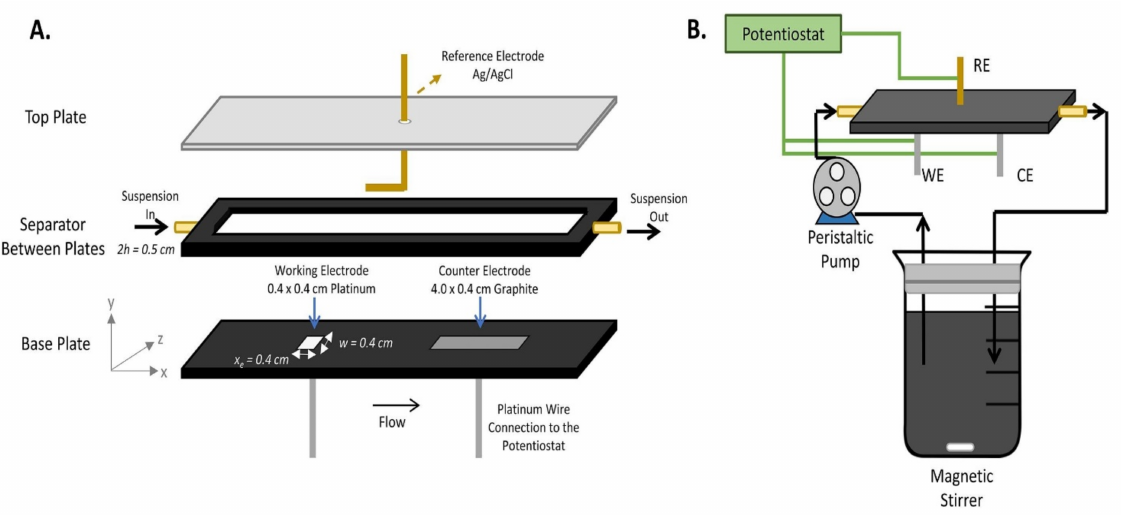
Figure 13. Hydro dynamic Cell. ( A ) Plates of Hydrodynamic Channel Cell (HCC) and ( B ) Electro- chemical system. Reprinted by permission from